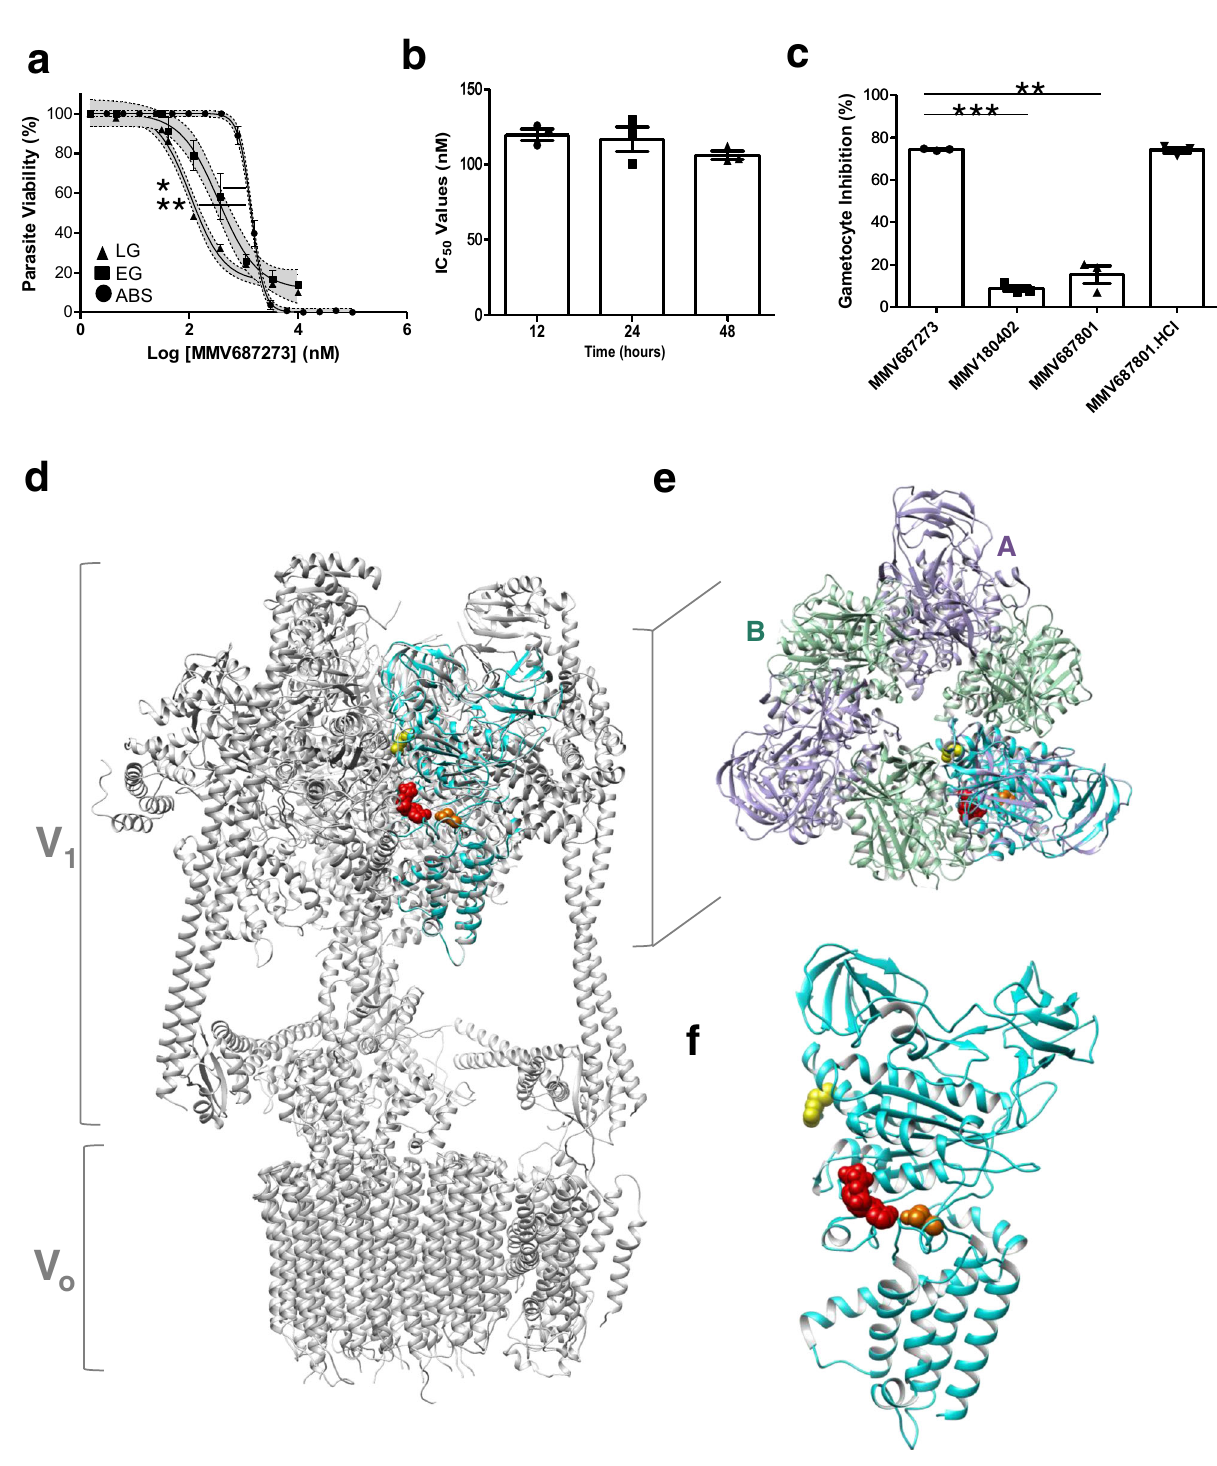
repression of known H3K9me3-associated genes involved in cell adhesion (Fig. 6c) 30 and DNA/chromatin-related processes, including three histone methyltransferases (SET7, 9 and 10), histone H3 and heterochromatin protein 1. Several Api-AP2 transcription factor family members also showed aberrant expression under ML324 pressure including Api-AP2-O3 (ooki- nete associated). Among the transcripts with increased abun- dance is another jmj family member, jmjC2 30 , and gametocyte- associated proteins gametocyte development 1 (gdv1) and male gamete gene 1 ( mdv1 ). The lack of removal of